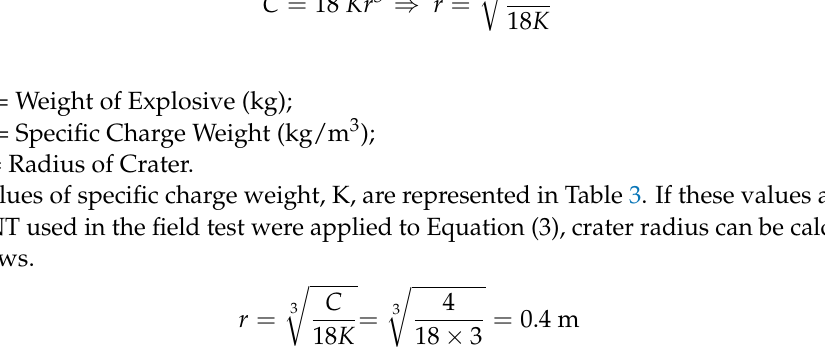
Table 2. Result of the Damage and Repair Range. Sort